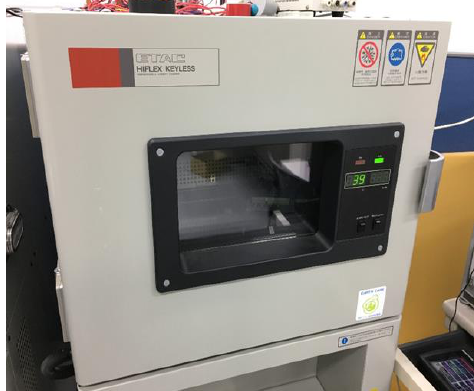
Figure A1. Thermo-hygrostat (HIFLEX KEYFLESS TL401E).